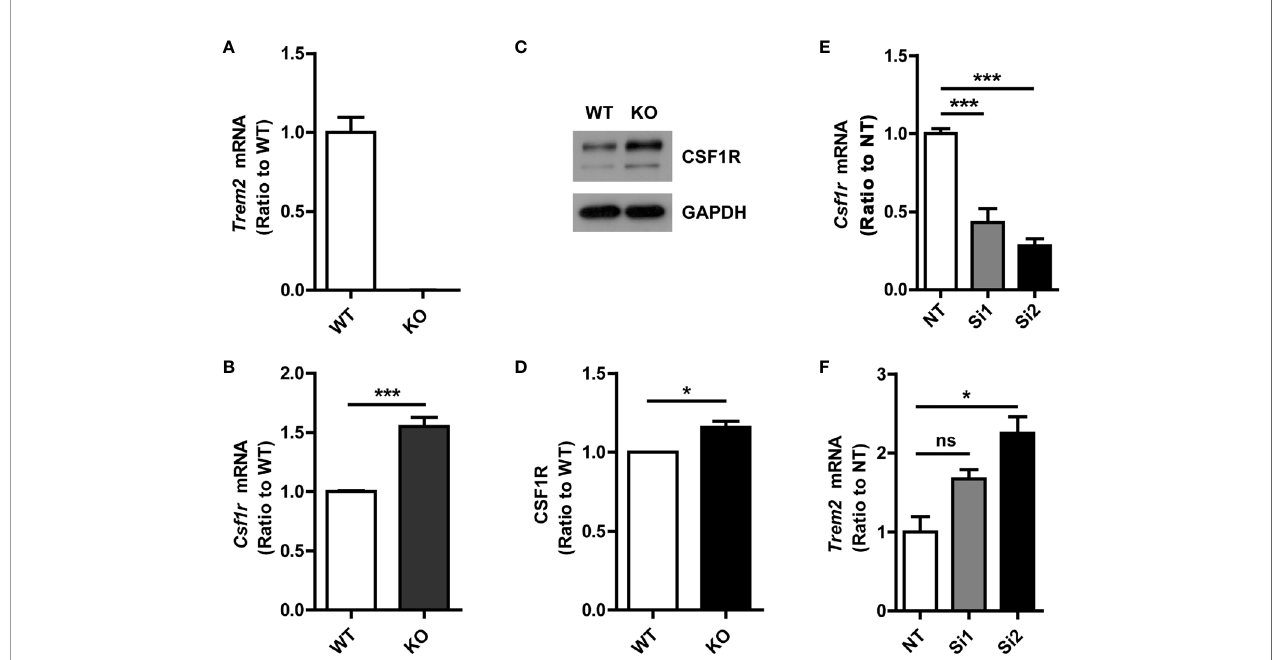
FIGURE 2 | Increased CSF1R expression in Trem2 -/- (knockout, KO) microglia. (A) Trem2 KO in mouse primary microglia was con fi rmed by qRT-PCR. (B) Csf1r mRNA increased in Trem2 KO primary microglia. (C) Representative images of Western blotting. (D) CSF1R was increased in Trem2 KO primary microglia. Protein levels of CSF1R were quanti fi ed by densitometry and are presented as ratios to GAPDH. (E) Csf1r was knocked down in primary microglia by two independent siRNAs and the knockdown ef fi ciency was assessed by qRT-PCR. (F) Trem2 mRNA was increased in Csf1r knockdown primary microglia. One-way ANOVA with Dunnett ’ s multiple comparison test. Data are plotted as mean ± SEM (n=3). * p <0.05; *** p <0.001; ns, not signi fi